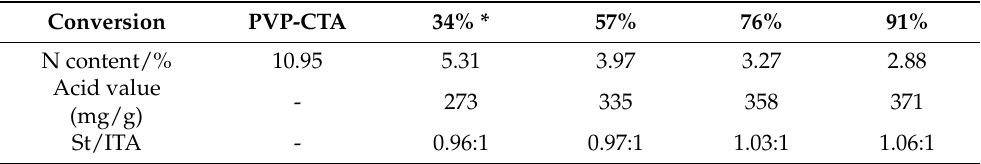
Table 2. St/ITA molar ratio of chain extension product at different conversion rates.